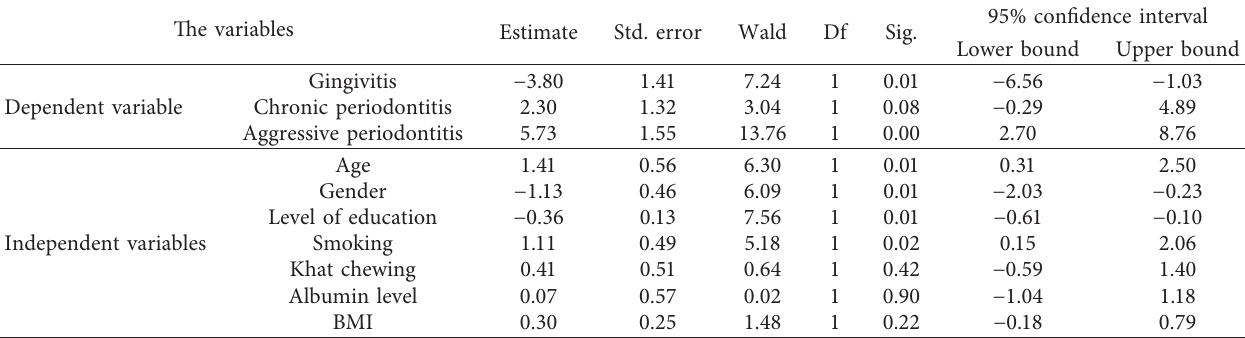
Table 3: Association between periodontal diseases and age, gender, level of education, smoking, khat chewing, BMI, and albumin level. The variables